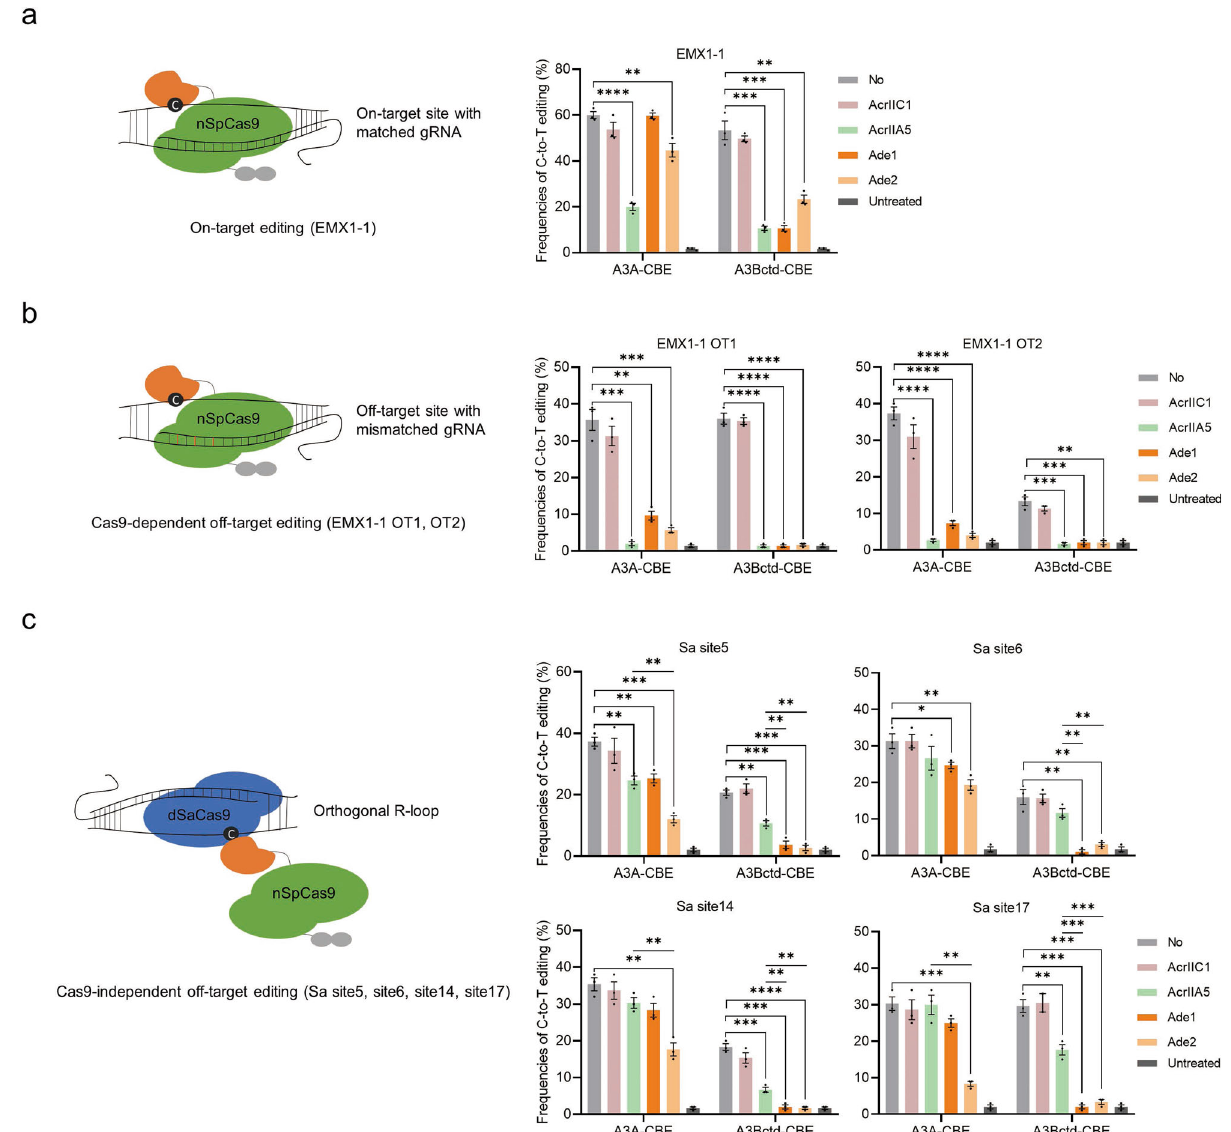
Fig. 5 Evaluation of Cas9-dependent and Cas9-independent OT editing. The principle of the assay is illustrated on the left, and the results are shown as bar graphs on the right. a On-target editing frequencies of A3A and A3Bctd-CBE in the presence or absence of AcrIIC1 (as a negative control), AcrIIA5, Ade1 and Ade2 at the EMX1-1 site. b Cas9-dependent OT editing frequencies of A3A and A3Bctd-CBE in the presence or absence of AcrIIC1 (the negative control), AcrIIA5, Ade1 and Ade2 at the EMX1-1 OT1 and OT2 sites. c Cas9-independent OT editing frequencies of A3A and A3Bctd-CBE in the presence or absence of AcrIIC1 (the negative control), AcrIIA5, Ade1 and Ade2 at Sa site5, site6, site14 and site17. The dSaCas9 together with a gRNA was used to induce a stable ssDNA region (orthogonal R loop) at a speci fi c locus, thus arti fi cially magnifying Cas9-independent deamination. Values and error bars re fl ect the mean ± s.e.m. and n = 3 biologically independent experiments. All p values were calculated by two-sided t tests. * p < 0.05, ** p < 0.01, *** p < 0.001, **** p < 0.0001. Source data are provided as a Source Data fi